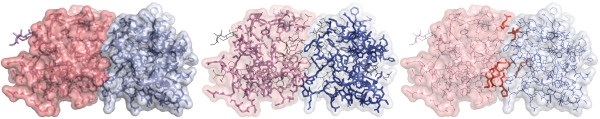
The protein–domain–residue hierarchy. Two bound proteins and their interacting domains and residues, captured in PDB complex 4IOP. The proteins are a Killer cell lectin-like receptor (in violet) and its partner, a C-type lectin domain protein (in blue). (Left) Interaction as visible from the contact surface. (Center) The two C-type lectin domains instantiating the interaction. (Right) Effectively interacting residues in red.